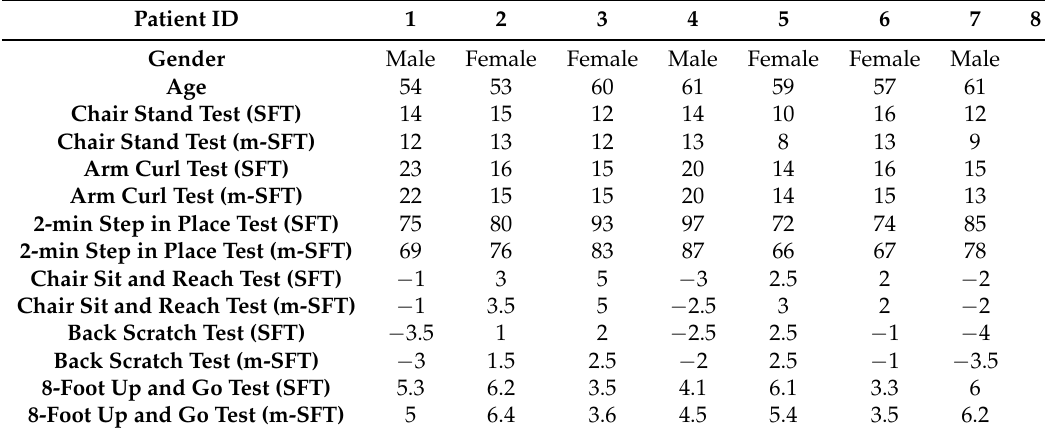
Table 2. Case study results.